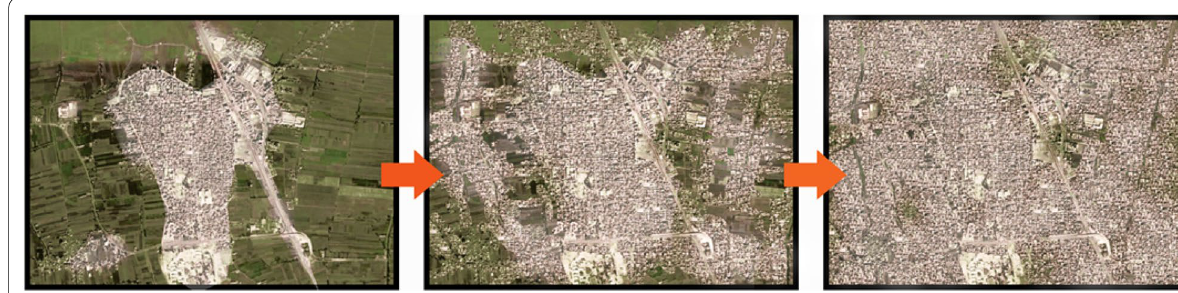
Fig. 1 Gradual encroachments on agricultural lands (researcher)